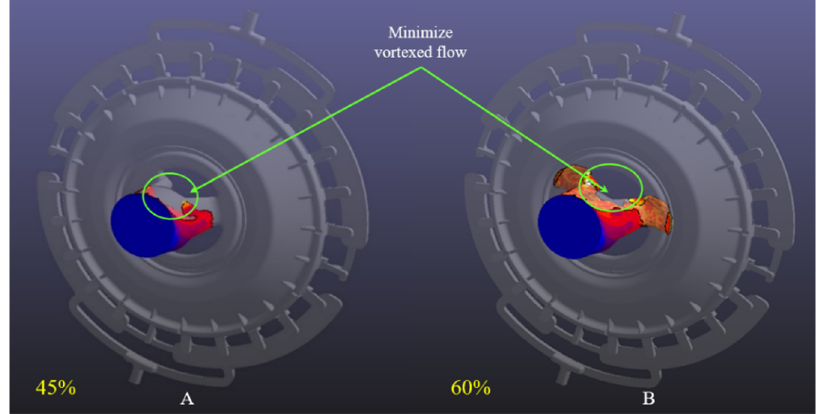
Figure 8. Simulation results of the melt flow for Case 3: ( A ) 45% filling; ( B ) 60% filling.